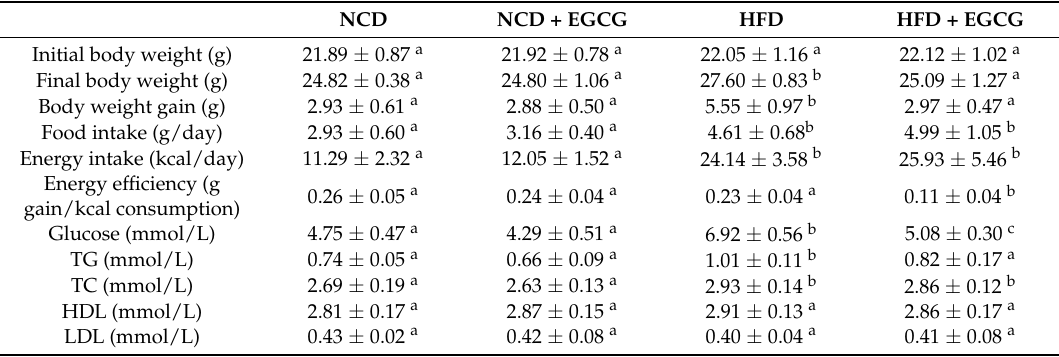
Table 3. Effect of ( − )-Epigallocatechin-3-gallate (EGCG) on body weight gain, food intake, and serum biochemical parameters.